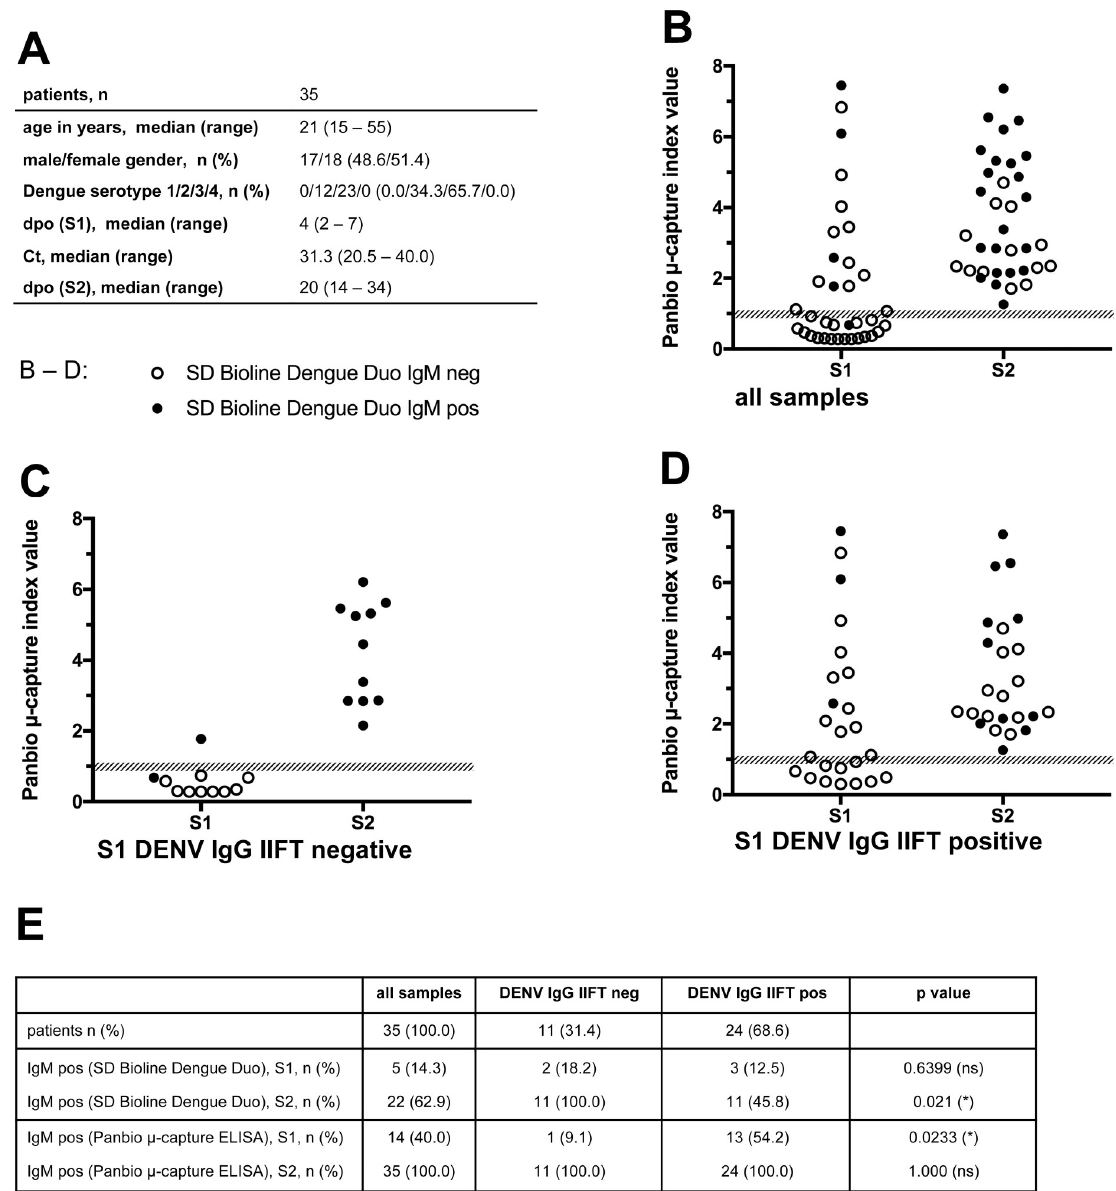
Fig 4. Seroconversion in DF patients detected by SD Bioline Dengue Duo IgM test and Panbio μ -capture ELISA. For 35 patients (A) both an acute phase serum sample (S1) and a follow-up sample taken during the convalescent phase (S2) were analyzed (B). Open/filled circles represent samples tested negative/positive in the SD Bioline Dengue Duo IgM test. Shaded areas represent index values rated as equivocal according to the respective manufacturer’s recommendations. (C) Subset of sample pairs with a DENV IgG IIFT negative S1 sample, ( D) Subset of sample pairs with a DENV IgG IIFT positive S1 sample. (E) Tabular summary of results. � : p < 0.05, ns: not